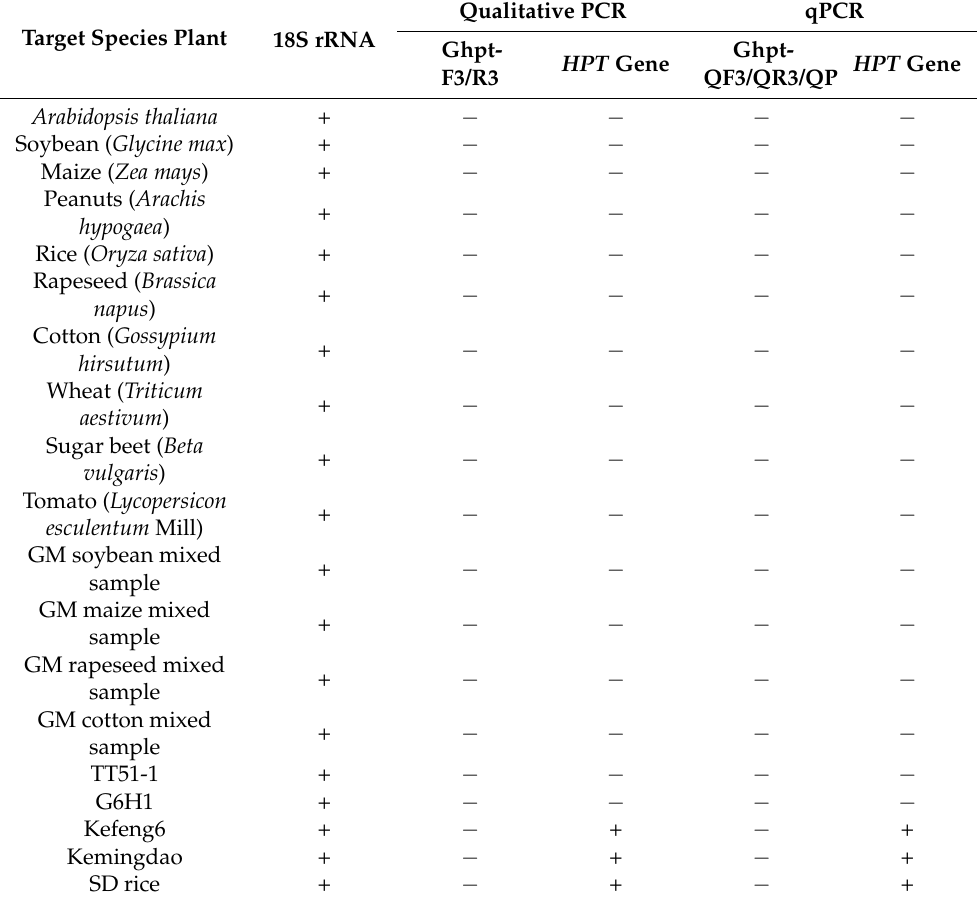
Table 1. Results of specificity tests for qualitative PCR and qPCR assays from different species of